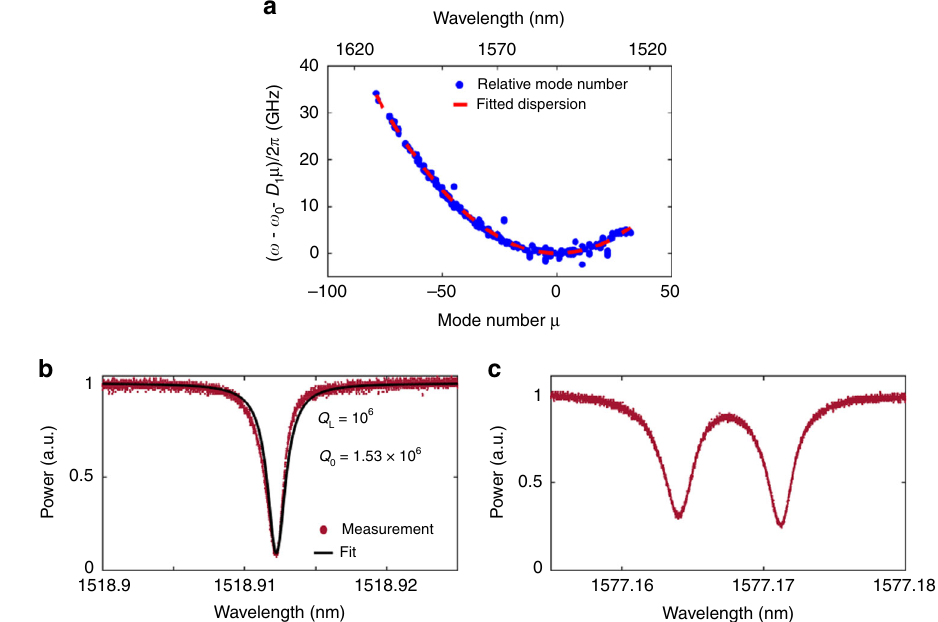
Fig. 3 Linear characterization of the resonator. a Measured relative mode frequencies D int plotted versus µ . b Measured transmission spectrum of a resonance around 1518 nm (red dots) and fi tting curve (black line). c Resonance with splitting due to backscattering (red